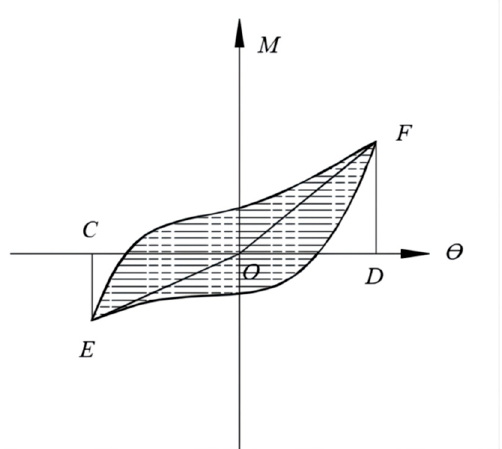
Figure 12. Schematic diagram of calculation method of equivalent viscous damping coefficient. The variation curve of the equivalent viscous damping coefficient he of each joint with the rotation angle is shown in Figure 13.